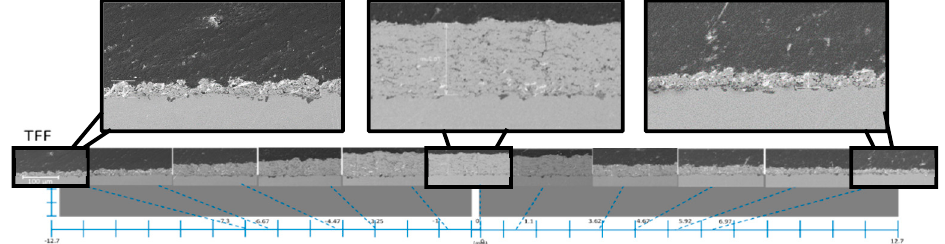
Figure 19. Cross-section images showing the structures developed in the flat fine grit-blasted sample (TFF).